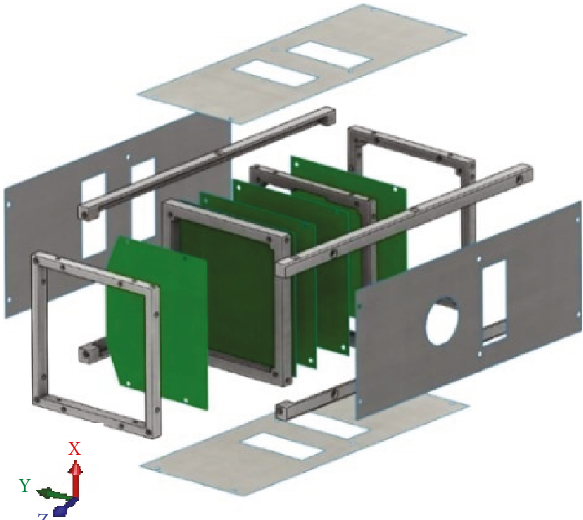
Figure 3: CAD design using surfaces and solid parts.